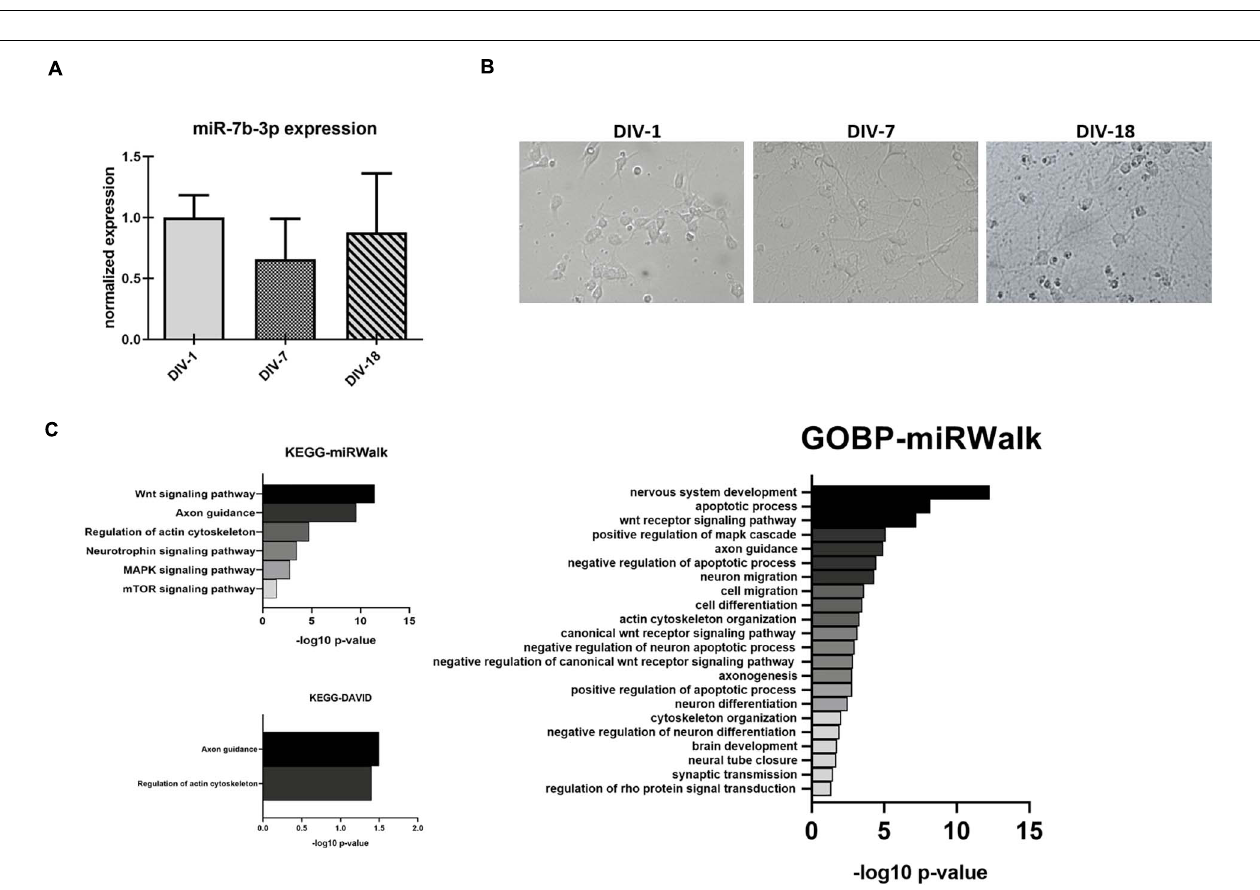
FIGURE 5 | miR-7b-3p expression and functional analysis in primary cortical neurons. (A) Developing in vitro cortical neurons, DIV-1 undifferentiated neuron stage, DIV-7 dendritogenesis stage, and DIV-18 mature neuron stage; (B) miR-7b-3p expression at DIV-1-7-18 presented as normalised relative expression value compared to DIV-1; (C) enriched annotation terms with a significant p -value analysed by miRWalk and DAVID 6.7 ( n = 3; values expressed as –log 10 p -value).